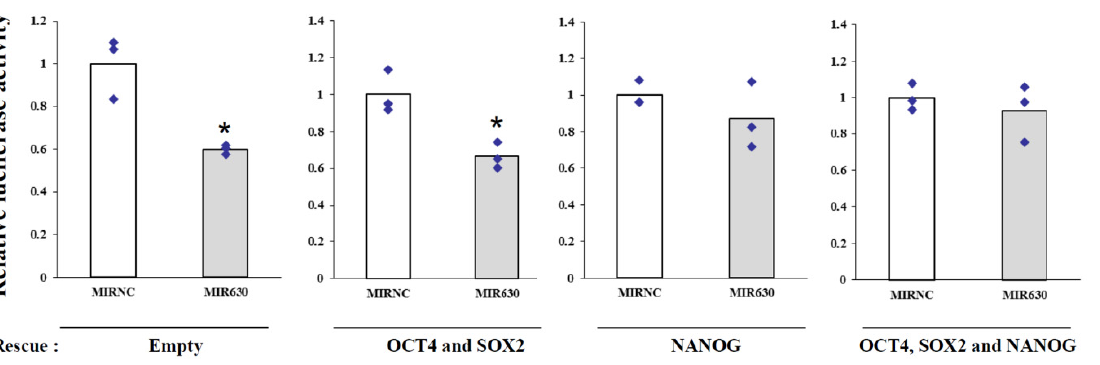
Figure 3. Ectopic OCT4, SOX2, and NANOG expression rescues MIR630-repressed NANOG transcriptional activity. (A) Luciferase reporter containing the NANOG promoter region was cotransfected with a negative control mimic (MIRNC) or MIR630 plus OCT4, SOX2, or/and NANOG expression vectors for 24 h in NT2/D1 cells. Luciferase activity was normalized to β -galactosidase activity and indicated as the relative activity to the corresponding negative control mimic (assigned as